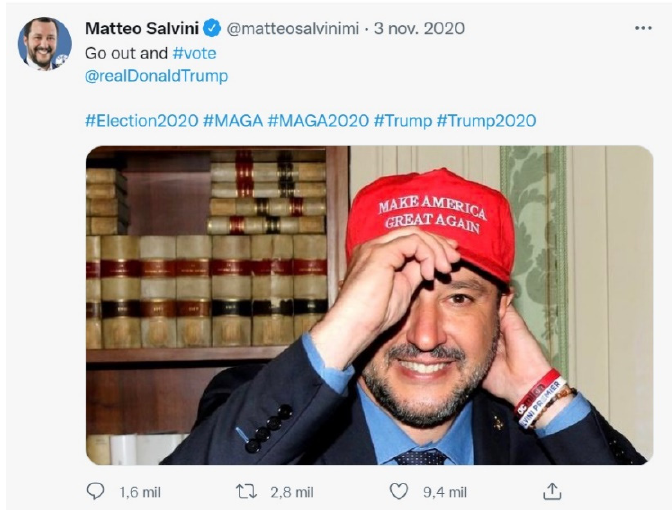
Figure 2. Tweet from Salvini referring to foreign affairs (US elections).